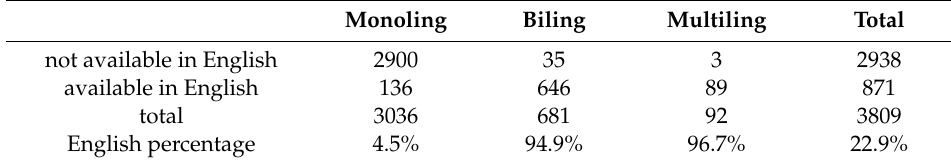
Table A44. English language availability (pt).